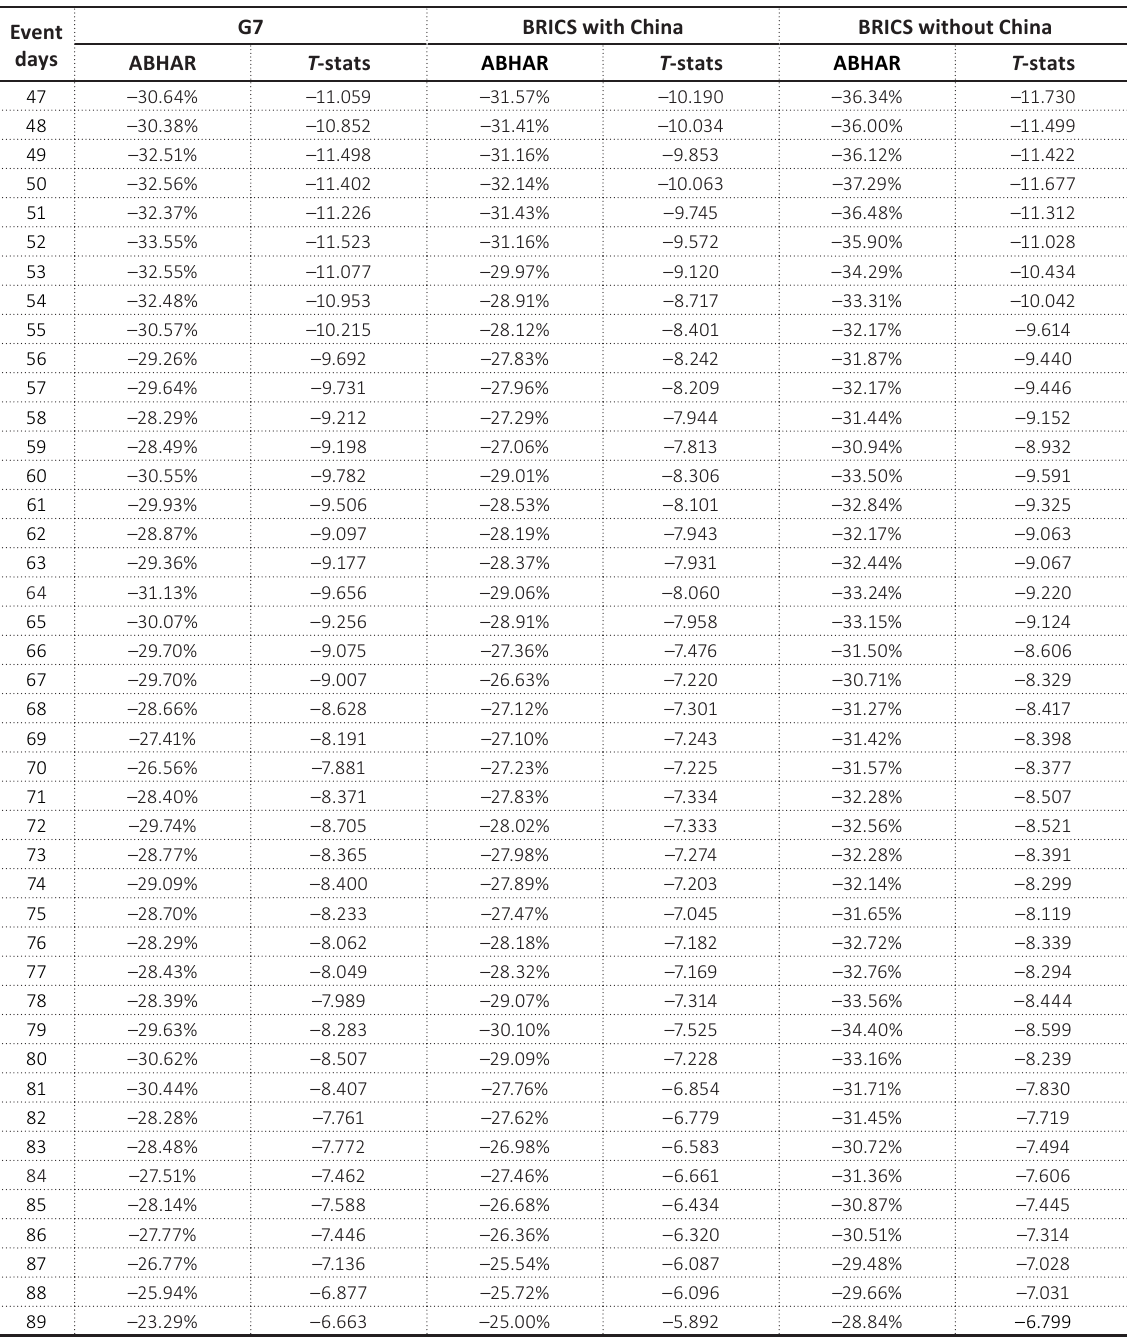
Table A1 (cont.) . ABHAR values with t-Stats for G-7 and BRICS except for China for a 90-day